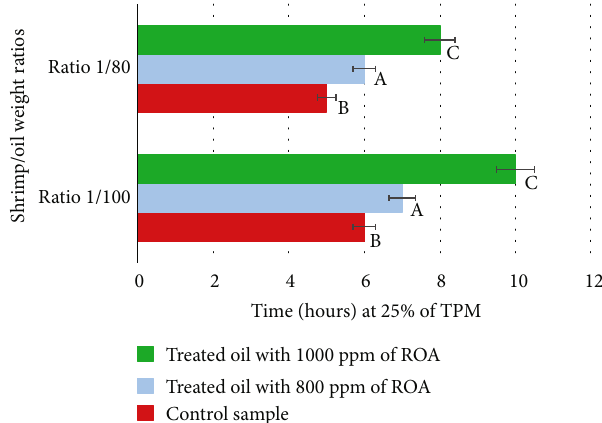
Figure 2: E ff ect of shrimp/oil weight ratios on the oil oxidation. The values followed by di ff erent letters (A, B, and C) are signi fi cantly di ff erent from each other at p < 0 : 05 .